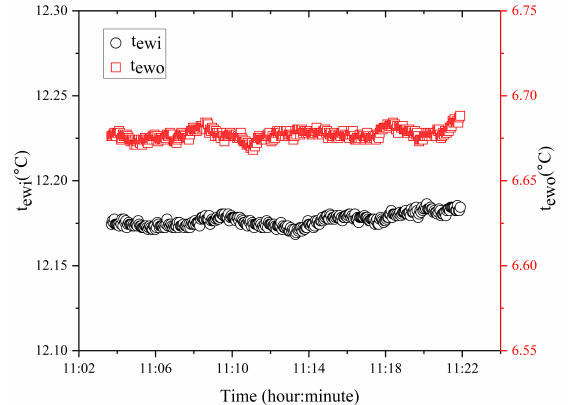
Figure 4. Evaporator inlet and outlet water temperature at 700 RT and 581 kg charge.